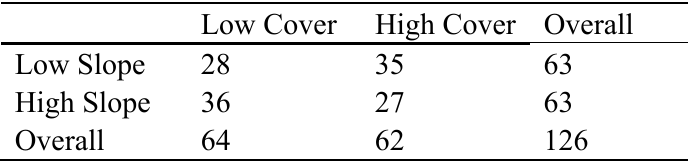
Table 2. Number of observations per